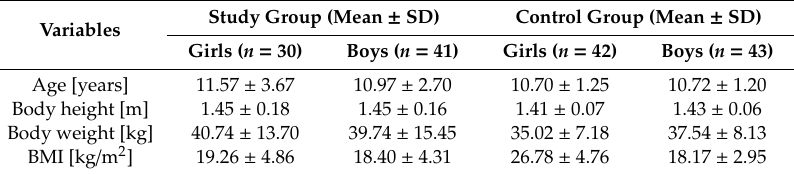
Table 1. Characteristics of four